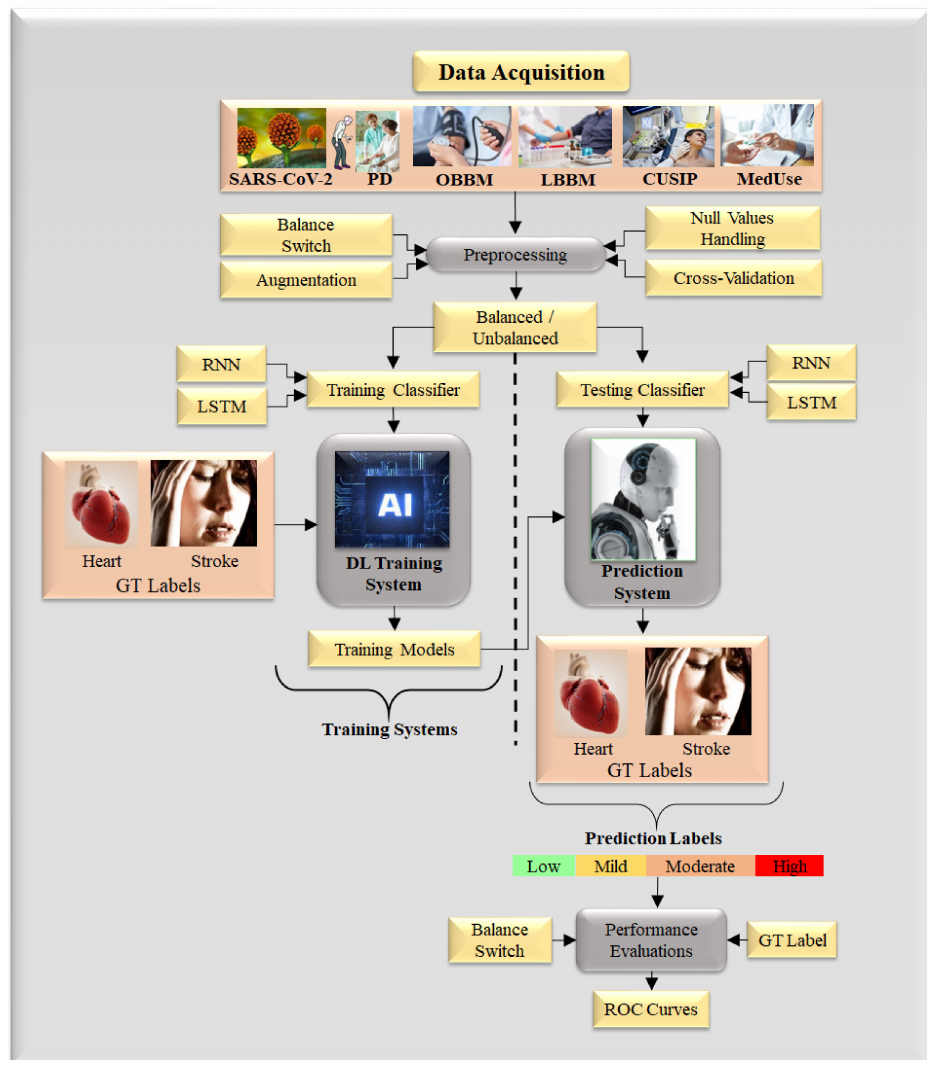
Figure 14. Deep learning model to predict the severity of CVD/stroke in PD with COVID-19 framework (Courtesy of AtheroPoint™, Roseville, CA,